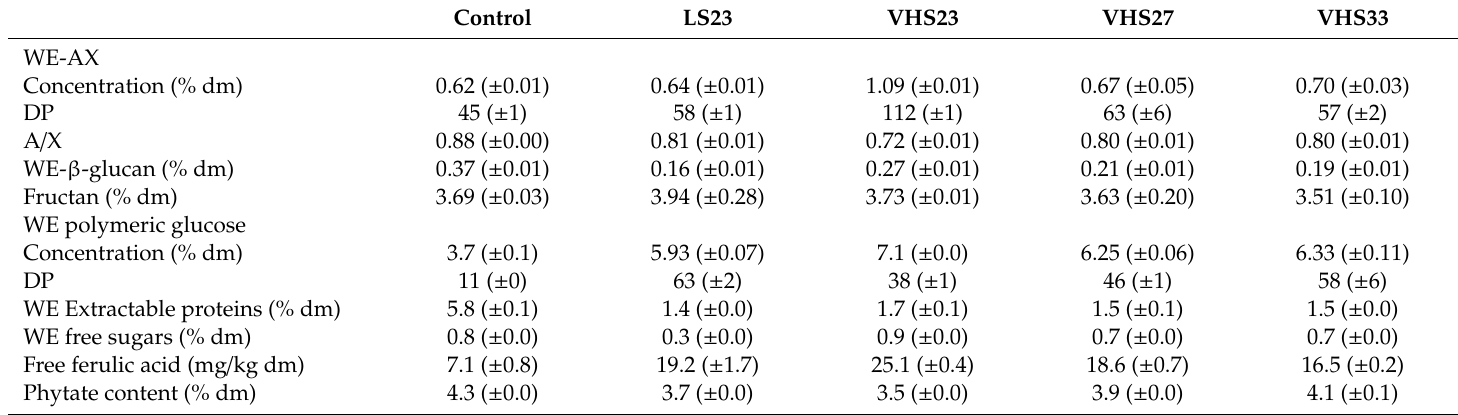
Table 4. Water-extractable arabinoxylan content (WE-AX), average degree of polymerisation (DP) of WE-AX, arabinose to xylose ratio (A / X), water-extractable (WE) β -glucan content, fructan content, WE polymeric glucose content, DP of WE polymer glucose, WE protein content, free sugar content (arabinose, xylose, fructose, glucose), free ferulic acid content and phytate content for the di ff erent samples: Control, LS23, VHS23, VHS27, VHS33. The data represent the means of triplicate measurements of one extrusion-cooking experiment. Standard deviations are indicated between